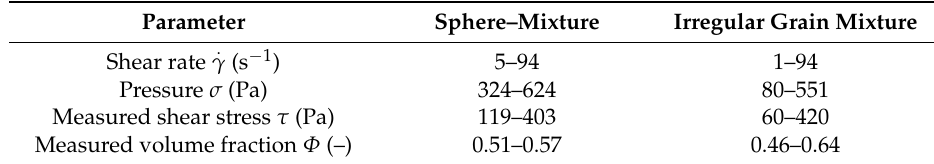
Table 3. Range of significant parameters during the